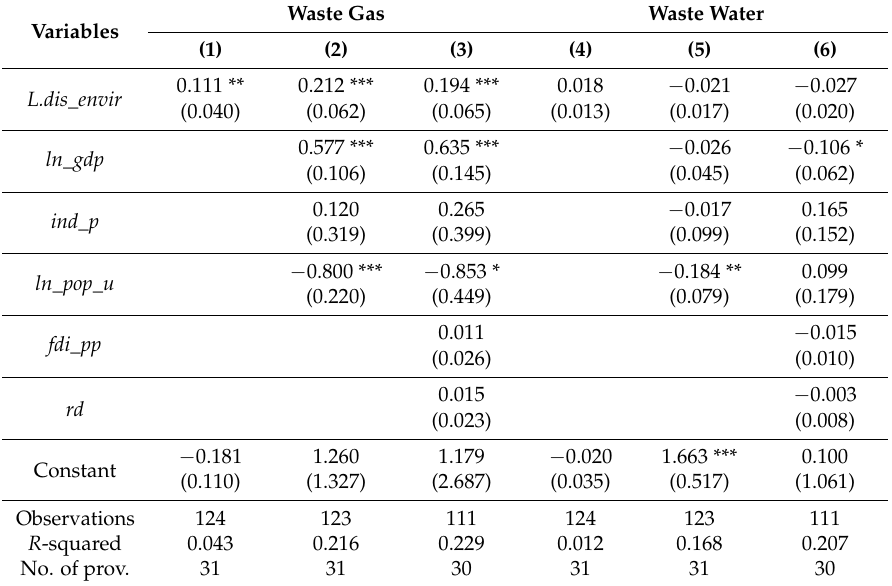
Table 4. Results of the response in waste water and waste gas governance investment vis- à -vis public environmental